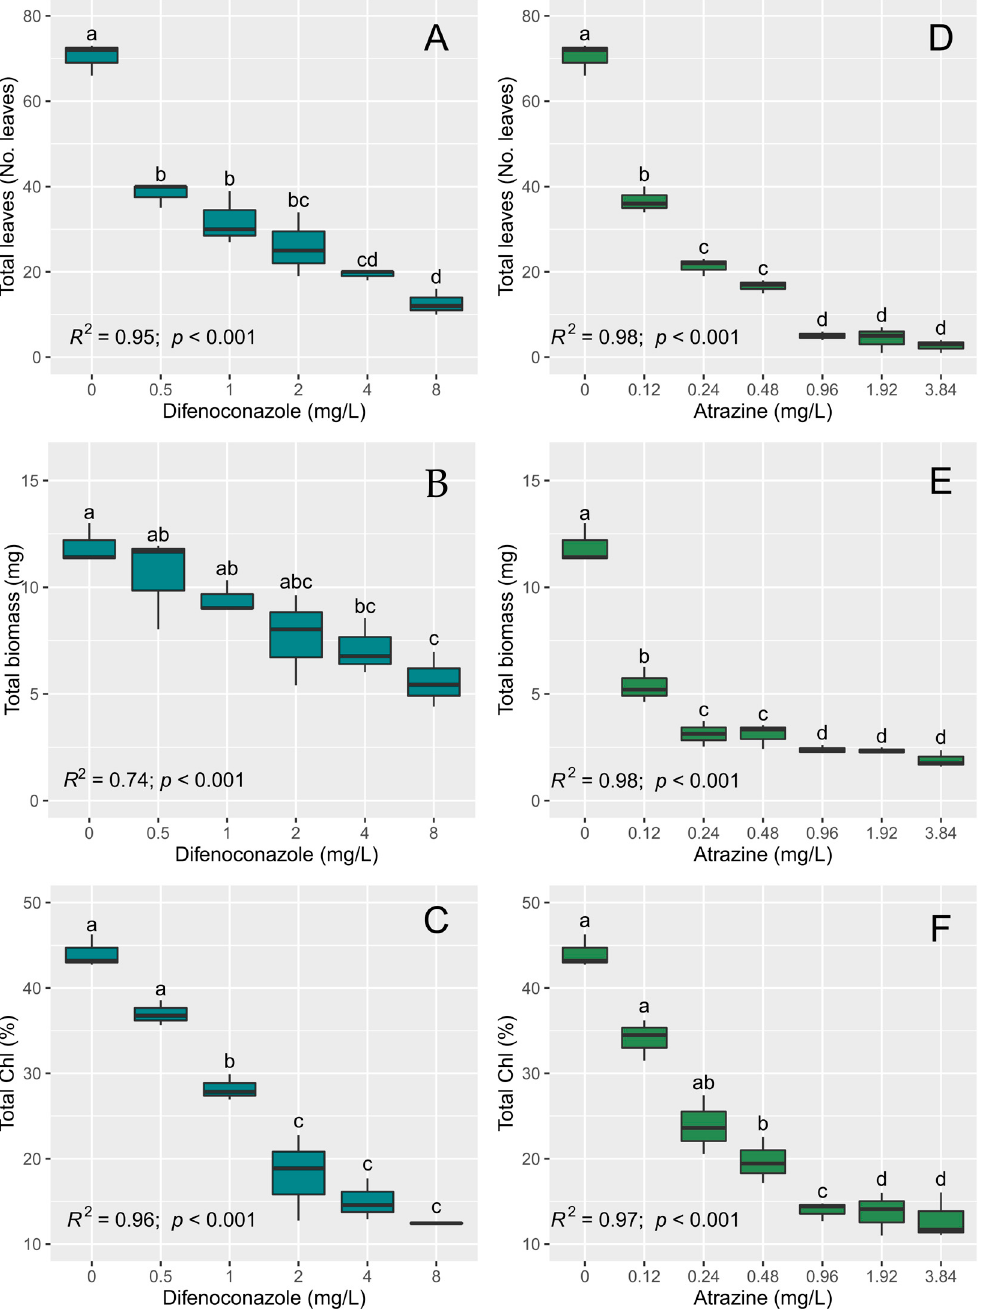
Figure 1. Effects of difenoconazole ( A – C ) and atrazine ( D – F ) after seven days of exposure on the number of leaves, total biomass, and total chlorophyll (Chl) content of Lemma minor . Different lowercase letters denote significant differences in the means at p ≤ 0.05 (pairwise comparisons) between different pesticide concentrations.